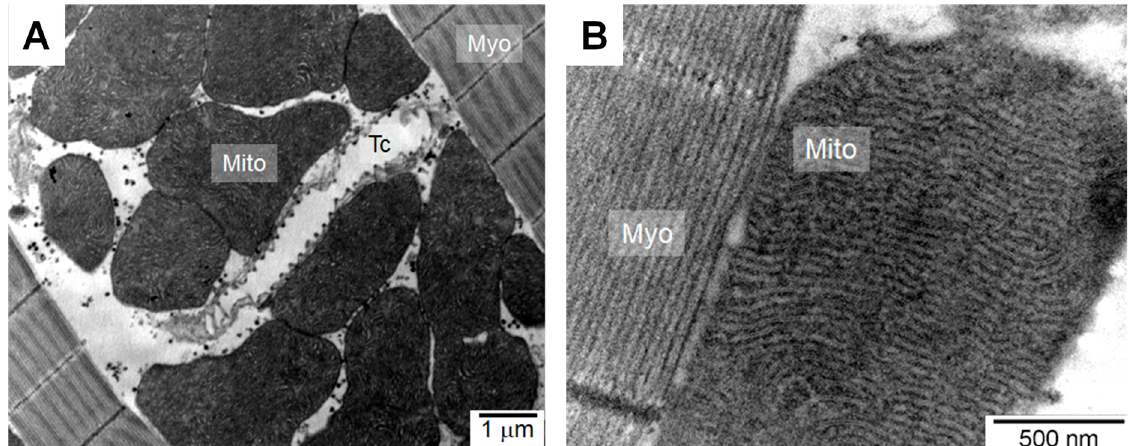
Figure 1. Transmission electron microscopy images of asynchronous flight muscles (AFM) biopsies from Aedes aegypti female mosquitoes. ( A ) The typical architecture of AFM longitudinal sections showing the high mitochondria (Mito) density localized alongside the myofibrils (Myo). Oxygen delivery to myocytes is made through a complex tracheae (Tc) network that lies adjacent to mitochondria. ( B ) Noteworthy is the extremely high cristae density and apposition, with barely visible matrix space.